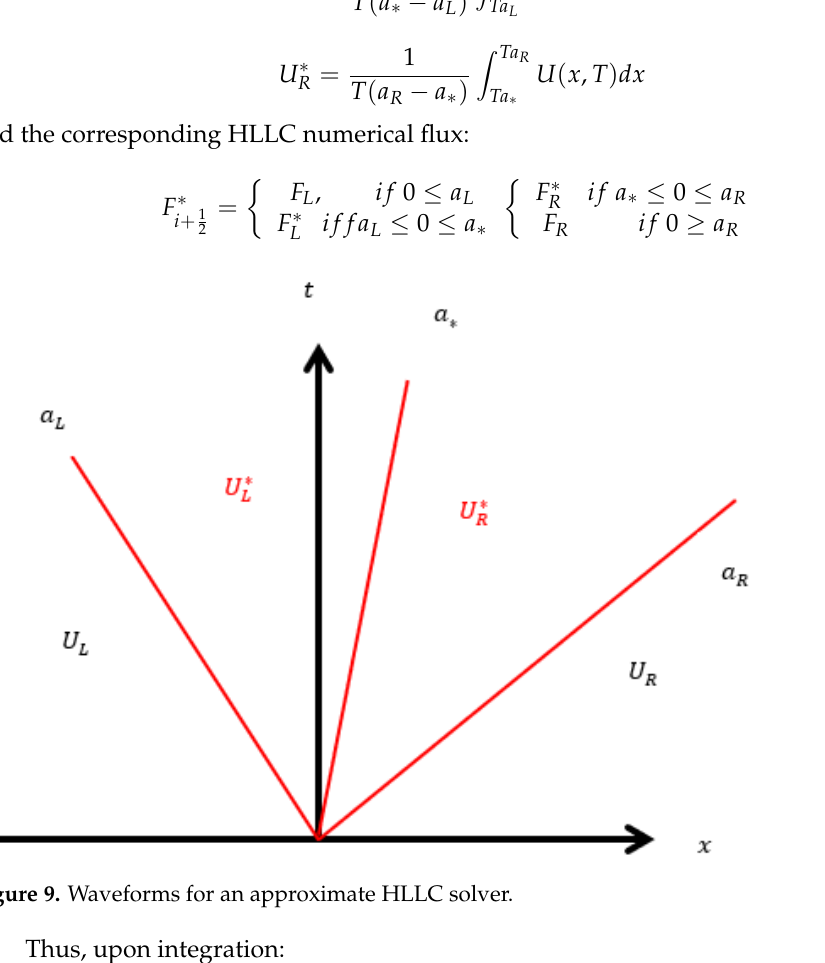
Figure 9. Waveforms for an approximate HLLC solver.